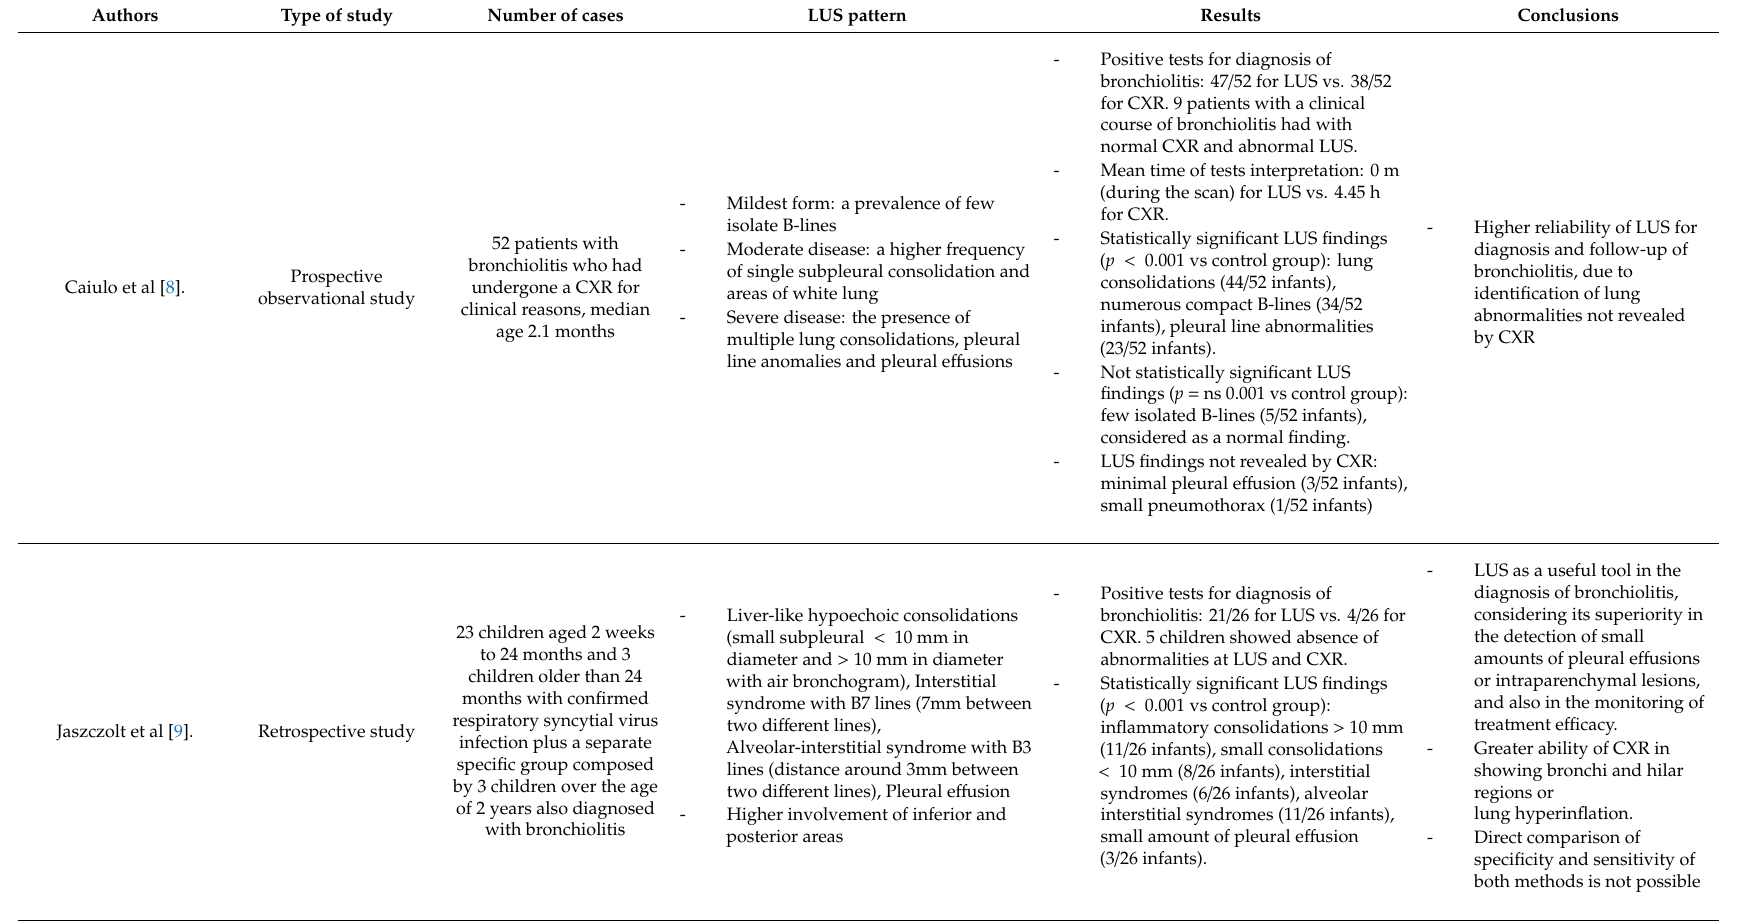
Table 1. Summary of the analyzed studies about the role of Lung Ultrasound (LUS) in the management of